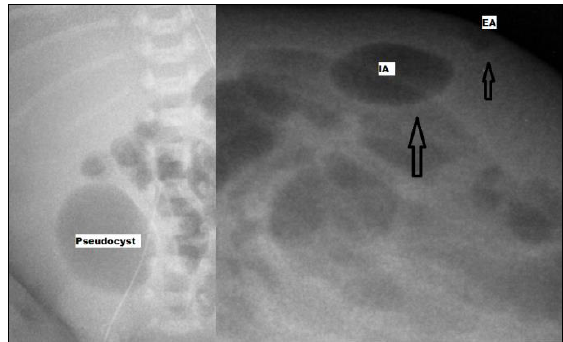
Figure 1: Initial AXR with loculated free gas in right lower abdomen and decubitus showing dumbbell swelling in lower abdomen.